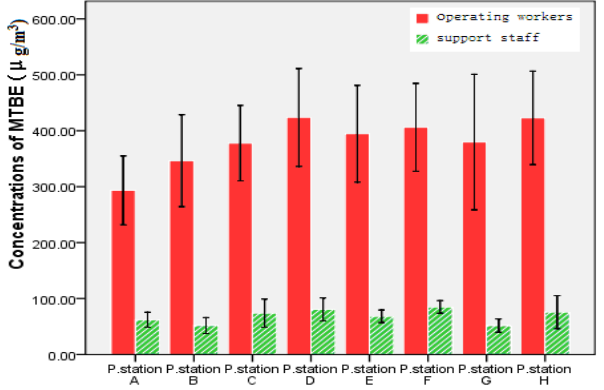
Figure 1. Average concentrations of personal exposure to MTBE in petrol station attendants.